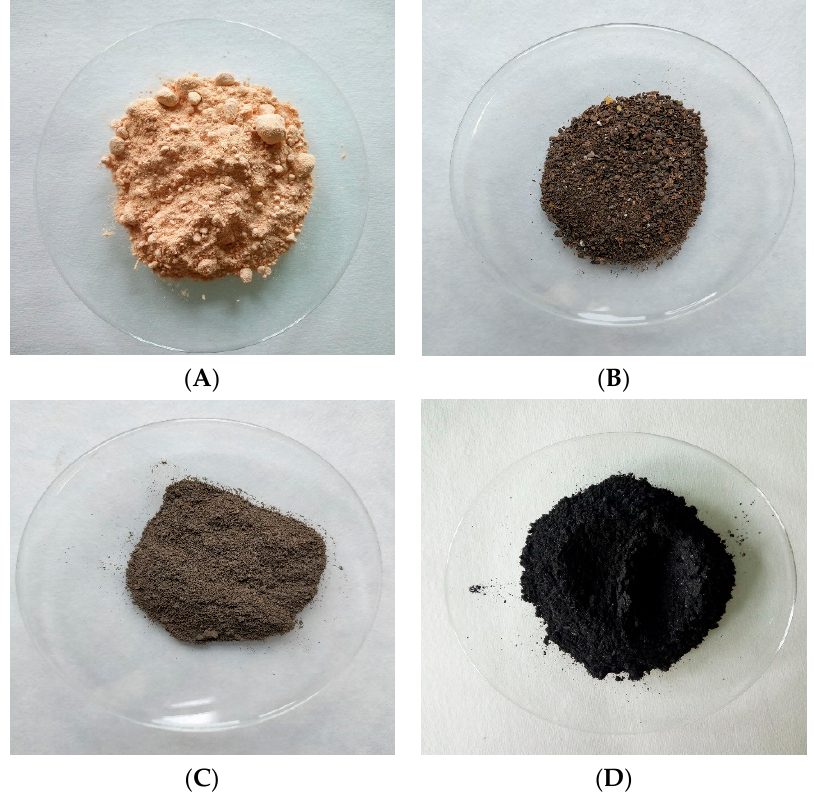
Figure 1. Materials used in the incubation experiment: ( A ) sulfur pulp, ( B ) manure, ( C ) digestate, ( D ) biochar.